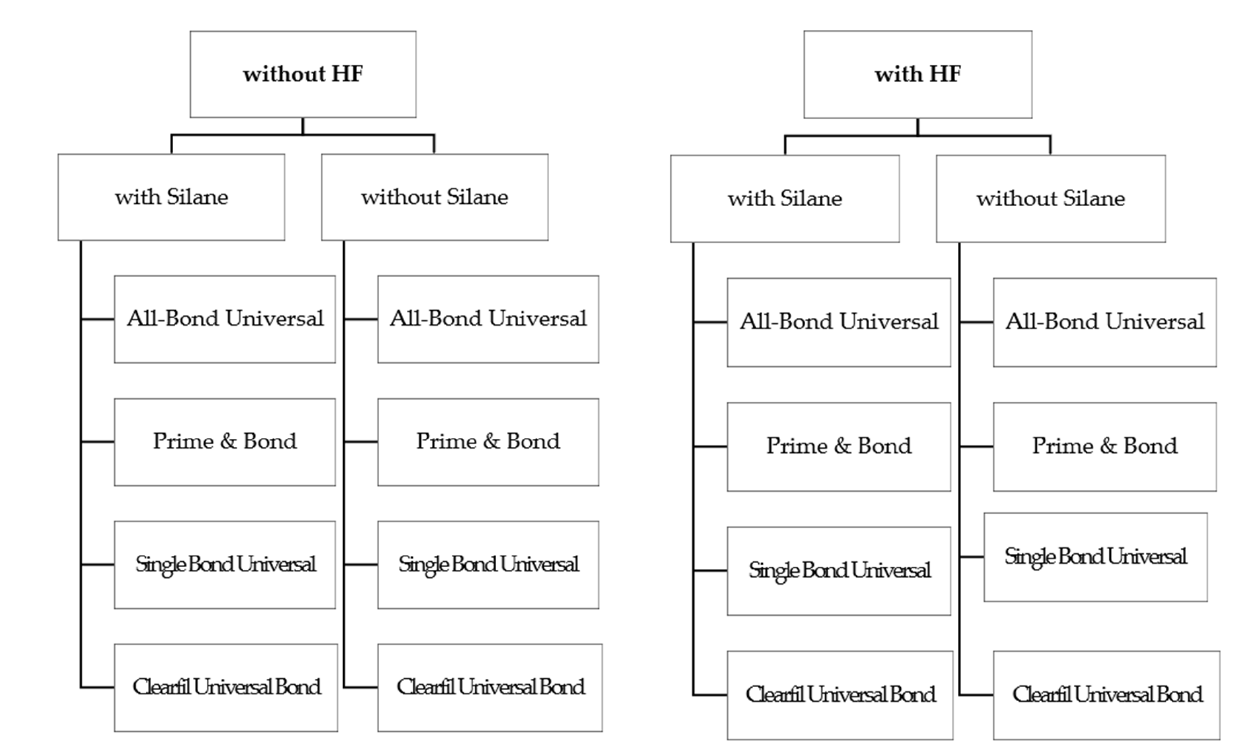
Figure 1. Group descriptions.